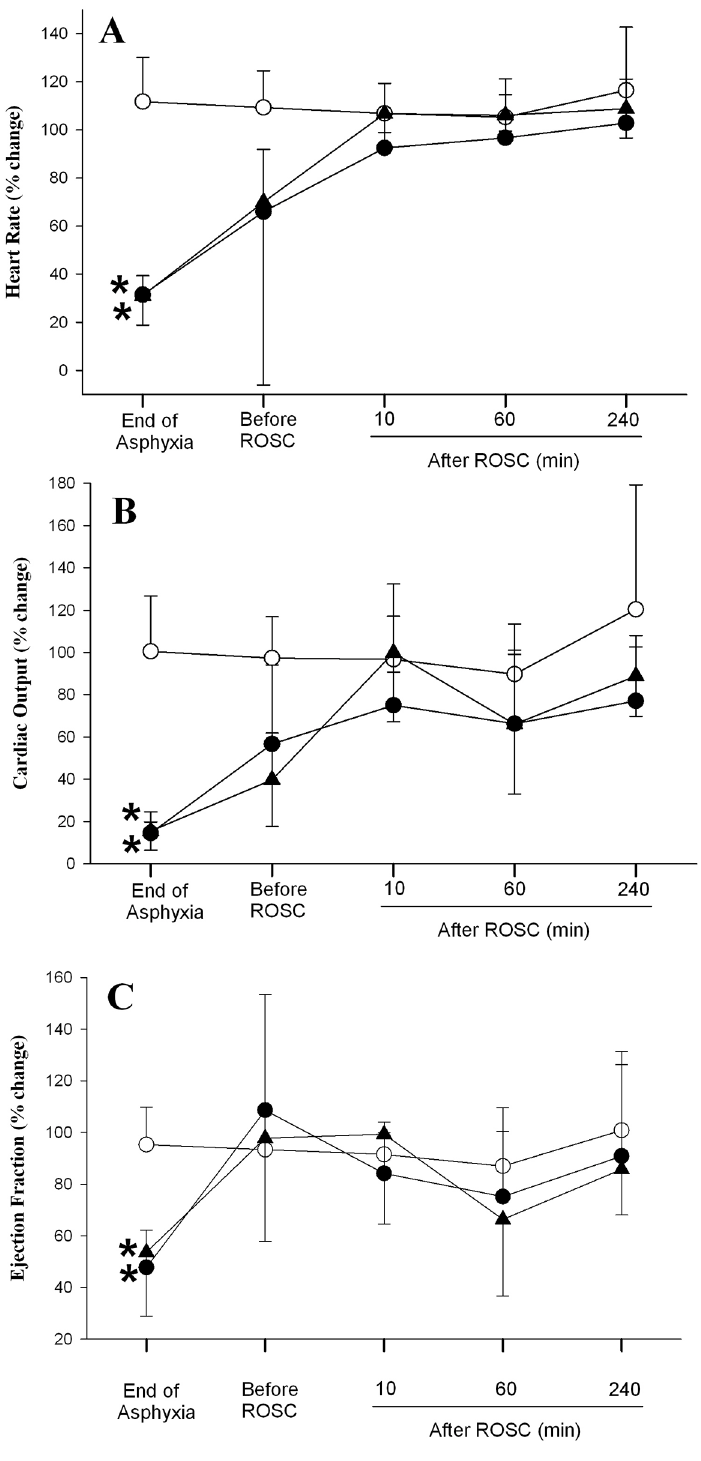
Fig 2. Percent changes from normoxic baseline in (A) heart rate, (B) cardiac output, and (C) ejection fraction in sham ( ◯ ), SI+CC 90 ( ● ), and SI+CC 120 ( ▲ ) groups during and after resuscitation. Each point represents mean ± SD. * Significantly different from sham-operated group, p < 0.05 (Tukey).